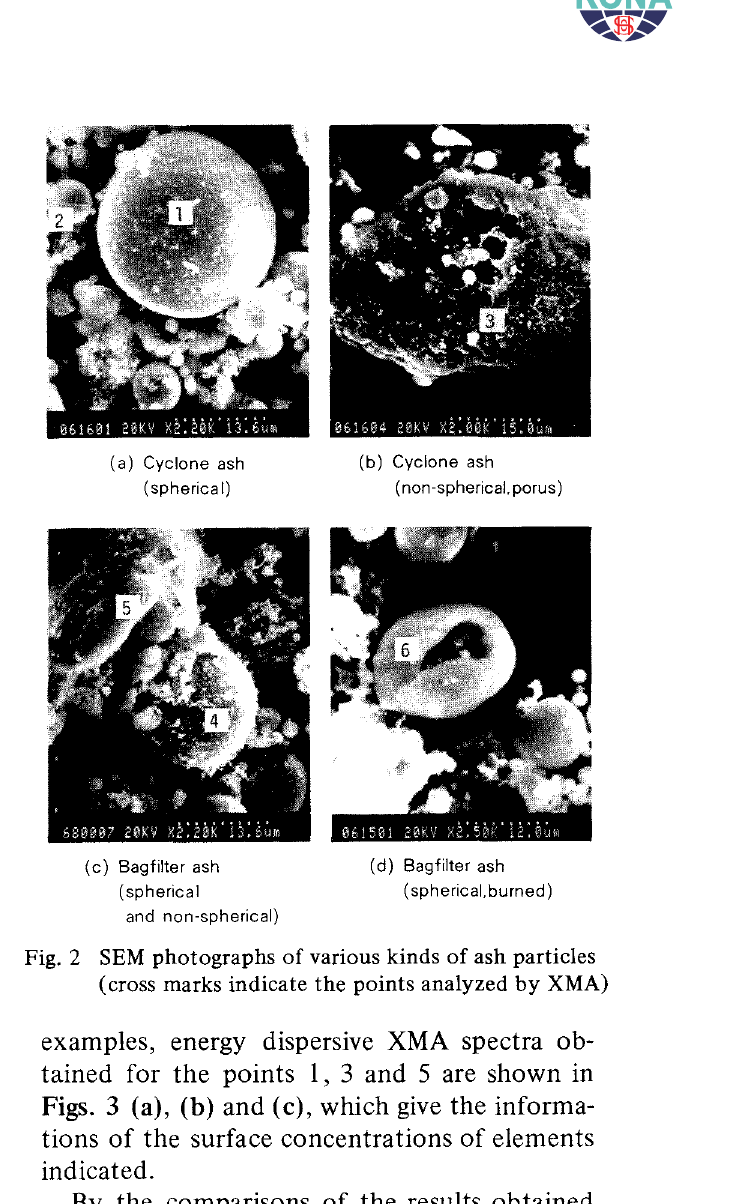
Fig. 2 SEM photographs of various kinds of ash particles (cross marks indicate the points analyzed by